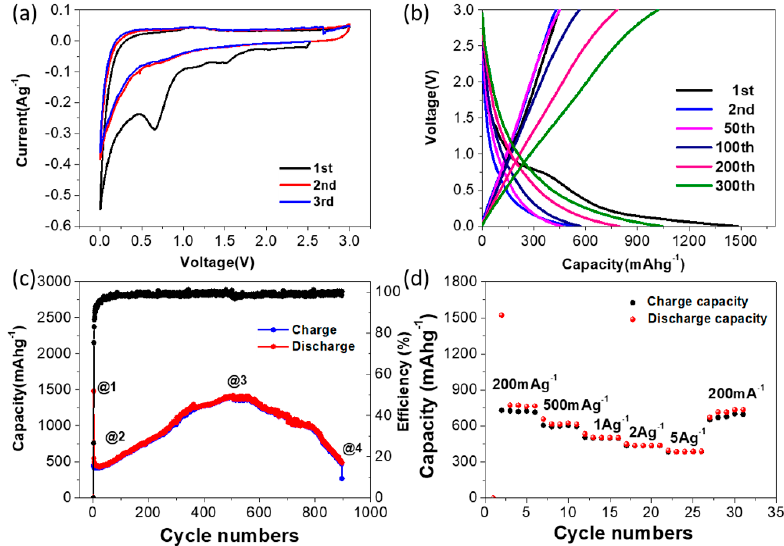
Figure 6. ( a ) First three CV curves of Si@C at a scan rate of 0.1mVs − 1 . ( b ) Galvanostatic charge- discharge curves of Si@C at a rate of 200mAg − 1 . ( c ) Full life cycling performance of Si@C at a rate of 200mAg − 1 . ( d ) Rate performance of Si@C at different